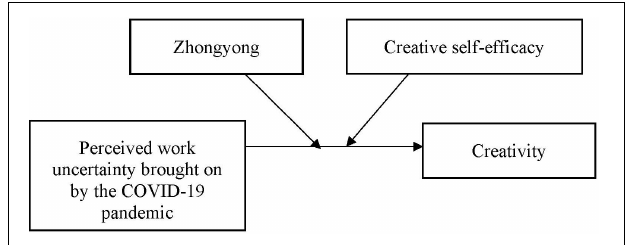
FIGURE 1 | Research